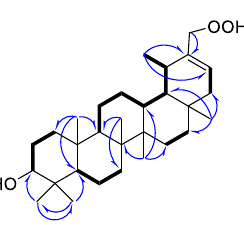
Figure 2. Main 1 H- 1 H COSY (bold lines), HMBC (blue arrows) correlations of compound